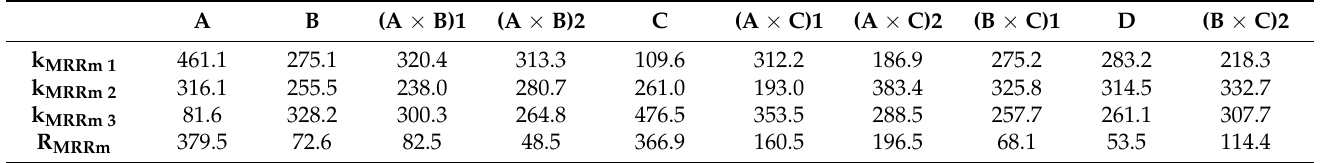
Table 4. Range analysis for MRR m